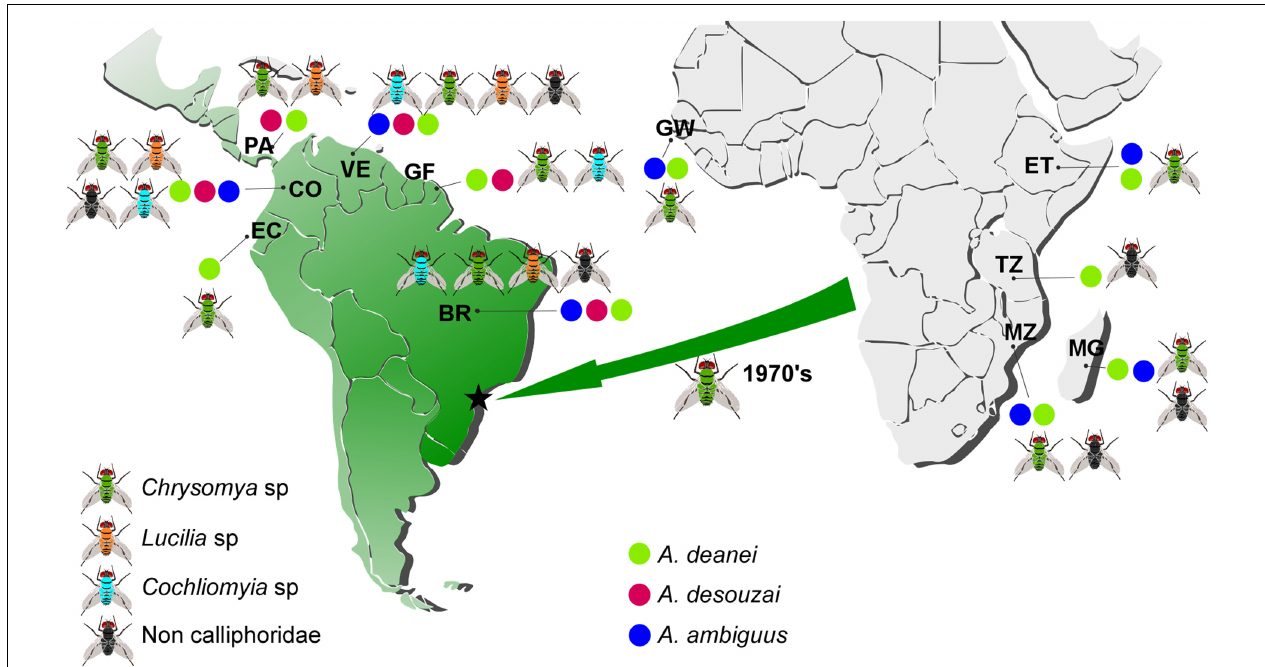
FIGURE 1 | Map indicating the collecting sites of flies and distribution of Angomonas species in Afrotropical and Neotropical regions. Blowflies of genera Chrysomya , Lucilia , and Cochliomyia were found infected with Angomonas deanei , A. desouzai , and A. ambiguus . The green arrow indicates the radiation of the African Chrysomya, and the green gradient its dissemination from Southern Brazil to across South and Central America. The black star indicates the site of the first reported Chrysomya in the Neotropic. BR, Brazil; VE, Venezuela; CO, Colombia; EC, Ecuador; GF, French Guiana; PA, Panama; GW, Guinea Bissau; ET, Ethiopia; TZ, Tanzania; MZ, Mozambique; MG,